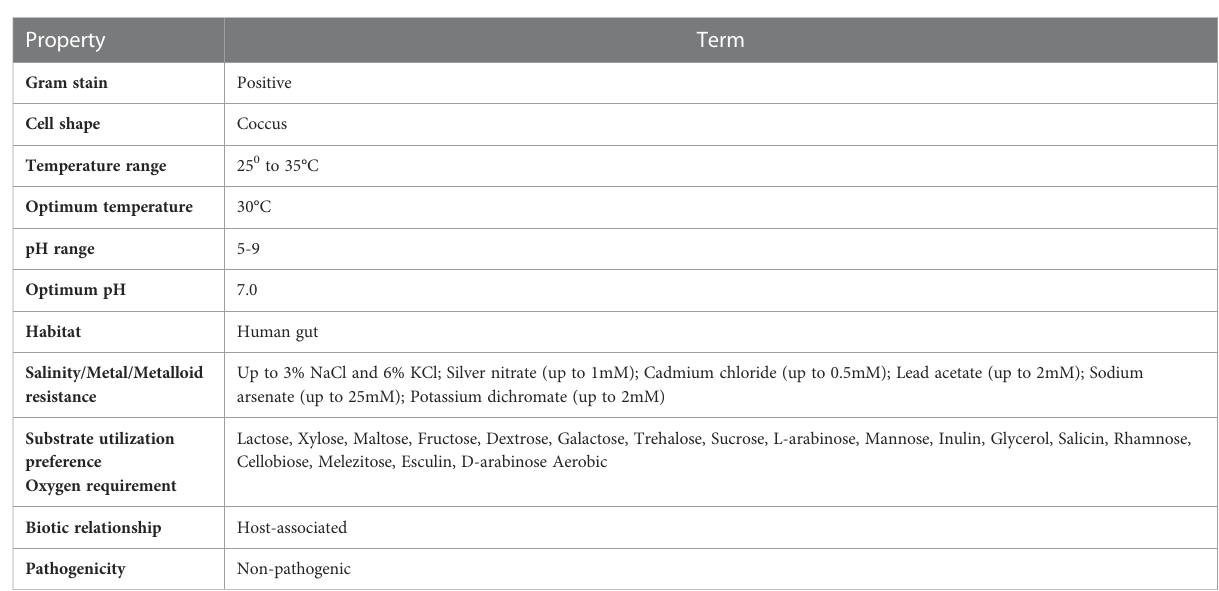
Sequence assembly of Cellulomonas sp. HM71 highlighted 239 contigs amounting to 3,643,765 base pairs with 62.14% GC content (Supplementary Table S3). A quantitative assessment of the completeness in terms of the expected gene content of a genome assembly or annotated gene set (https://busco.ezlab.org/) was done. The BUSCO assessment resulted in 100% genome assembly and 124 complete, 124 single copies, 0 duplicated copies, 0 fragmented, and 0 missing conserved proteins within the bacterial genome (Supplementary Table S3). Genome TABLE 1 Physiological, morphological, and biochemical characterization of Cellulomonas sp.